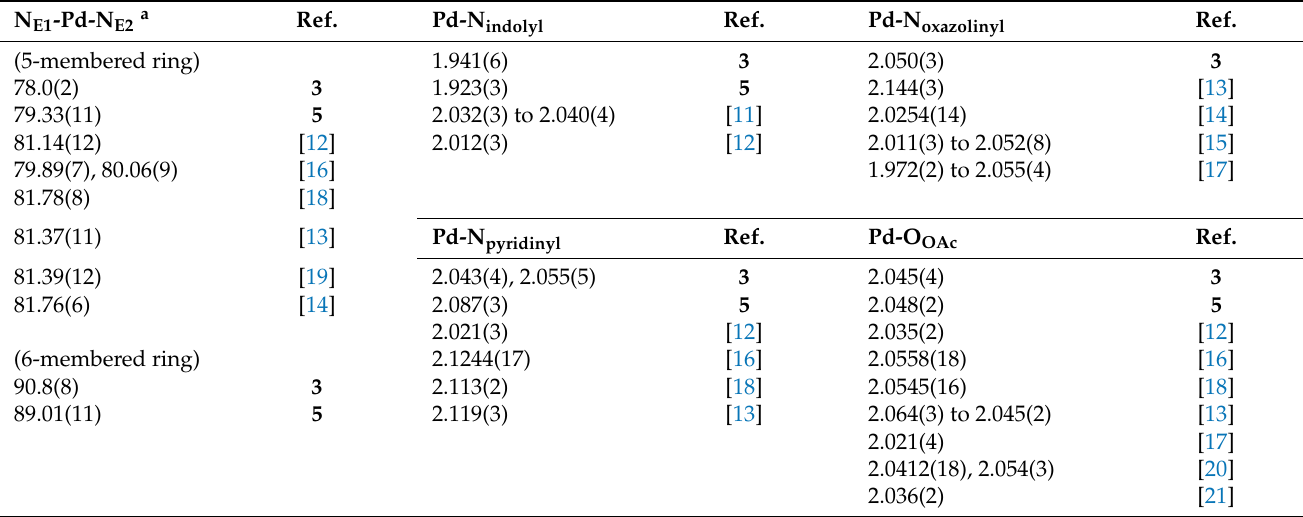
Table 1. Bite angles ( ◦ ) and bond distances (Å) compared with literature. N E1 -Pd-N E2 a Ref. Pd-N indolyl Ref. Pd-N oxazolinyl